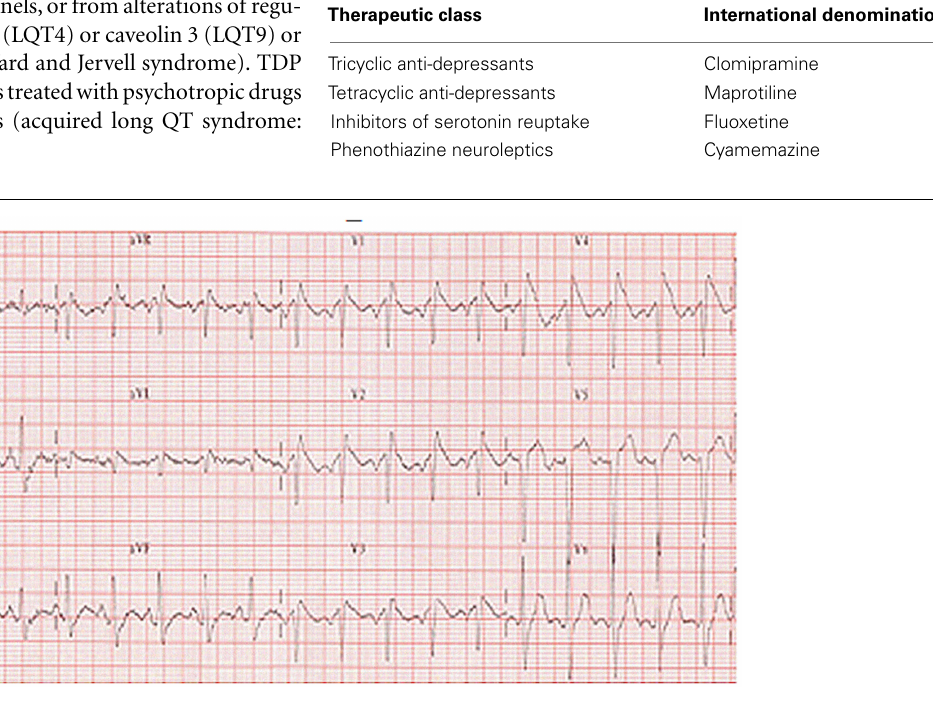
FIGURE 1 | Brugada syndrome. A = normal ECG; B = Brugada syndrome with right branch block and elevation of the ST segment.